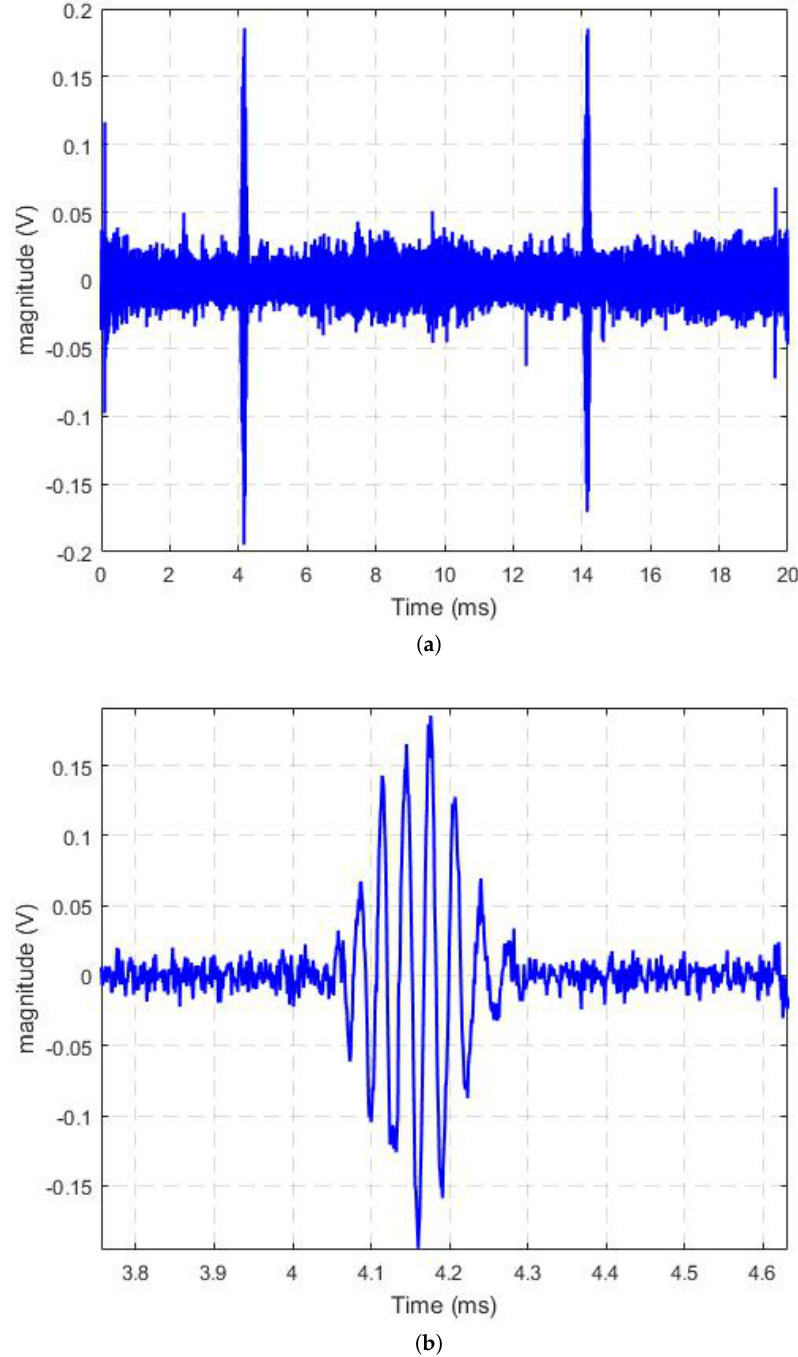
Figure 8. Noise measured in Italy without NBI ( a ) 20 ms time windwow; ( b ) short time